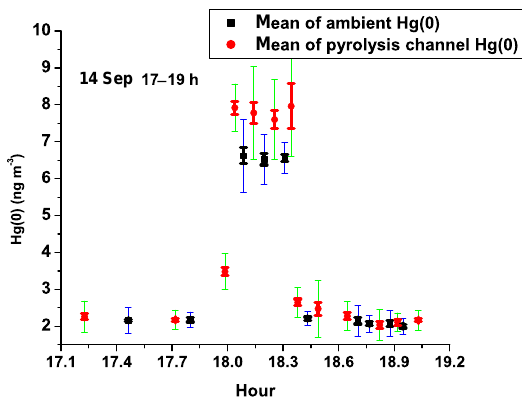
Figure 9. TOM concentrations calculated from the difference be- tween the pyrolyzed and ambient sample concentrations together with 2 SEs in the TOM concentrations. The reported HgBr 2 spike concentrations and DOHGS measurements are also shown.